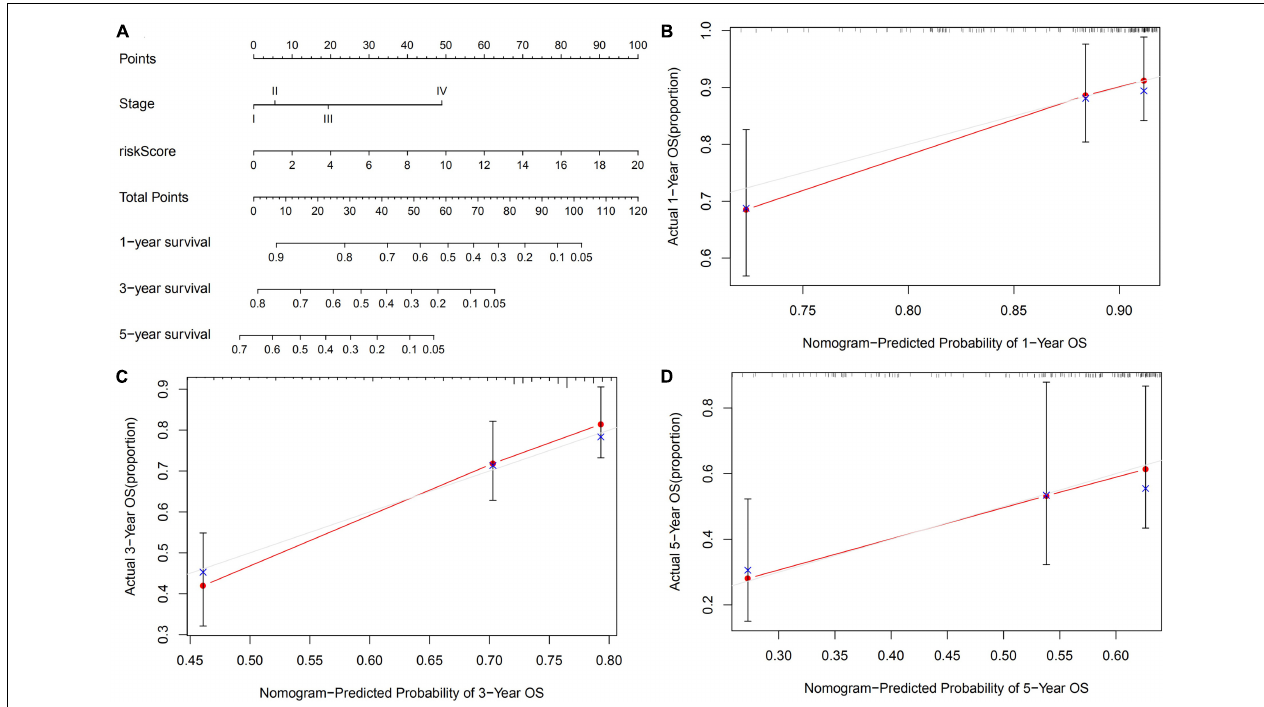
FIGURE 5 | Construction of an OS predicted nomogram. (A) A nomogram integrates the risk score of GIGSig with pathological stage to predict the OS at 1, 3, and 5 years of HCC. Calibration curves of OS at 1 (B) , 3 (C) , and 5 years (D) .